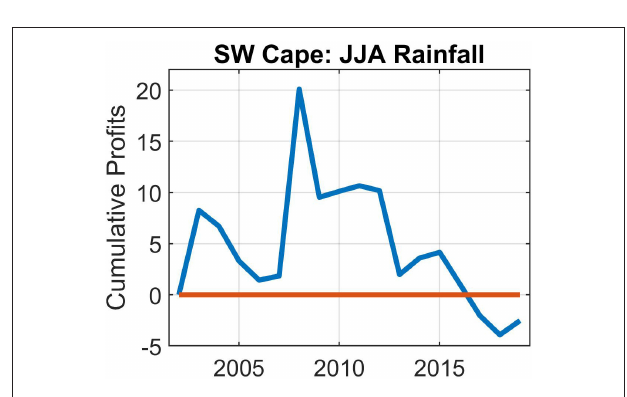
FIGURE 10 | As for Figure 6 , but for 18-years and for Jun-Jul-Aug rainfall forecasts for the farm located in the southwestern Cape of South